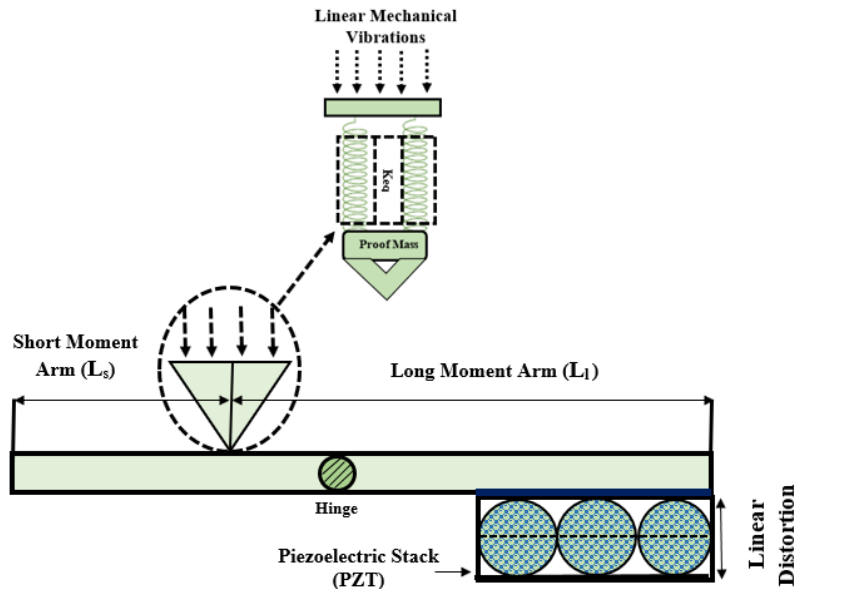
Figure 3. Analysis of mechanical vibration via conceptual design of VEM.